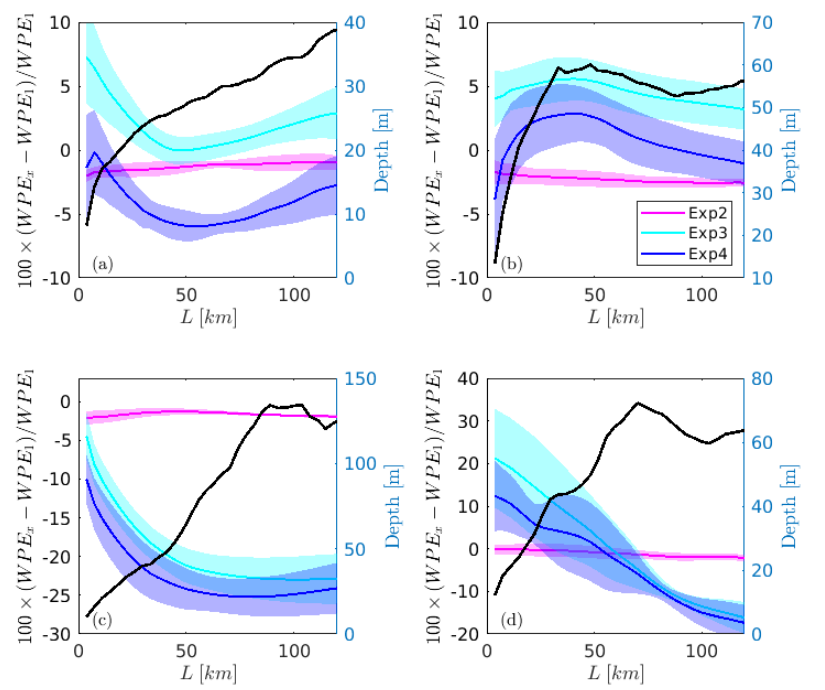
Figure 13. The relative difference of WPE between sensitivity experiments (i.e., Exp2, Exp3, and Exp4) and Exp1 for the four chosen areas: A ( a ), ( b ) B, ( c ) C and ( d ) D in July 2015. The shaded ares represent the standard deviation. The black solid lines represent the water depth changes with distance from the coastline.